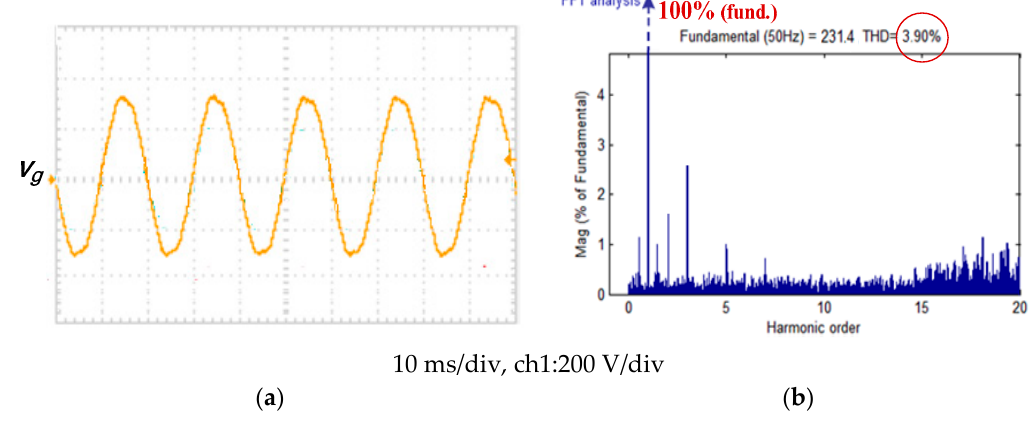
Figure 12. PCC grid voltage. ( a ) Grid voltage and ( b ) Grid current with its FFT analysis.